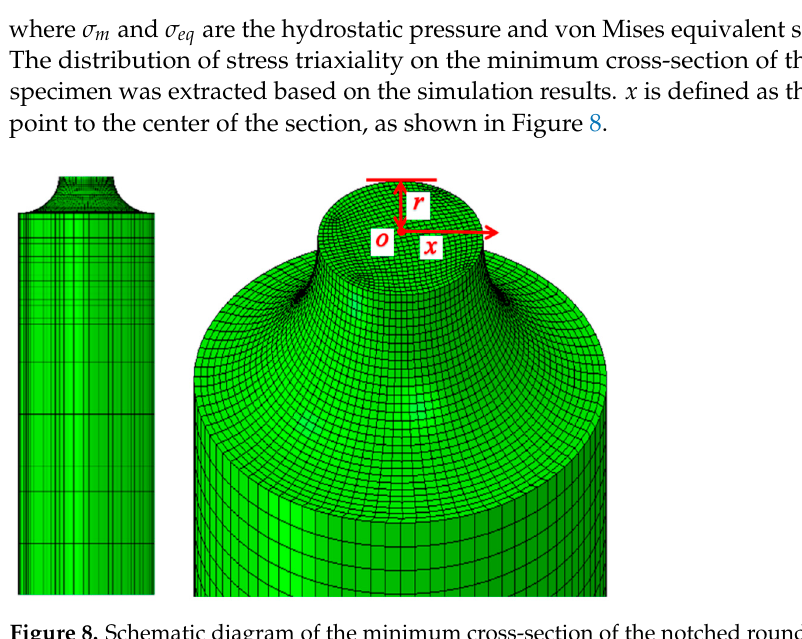
Figure 8. Schematic diagram of the minimum cross-section of the notched round bar specimen .